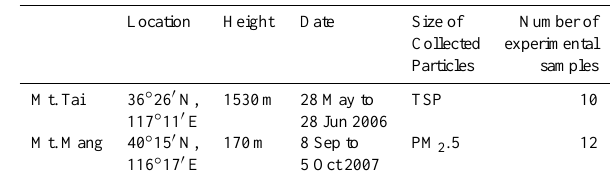
Table 1. Information of aerosol particle sampling